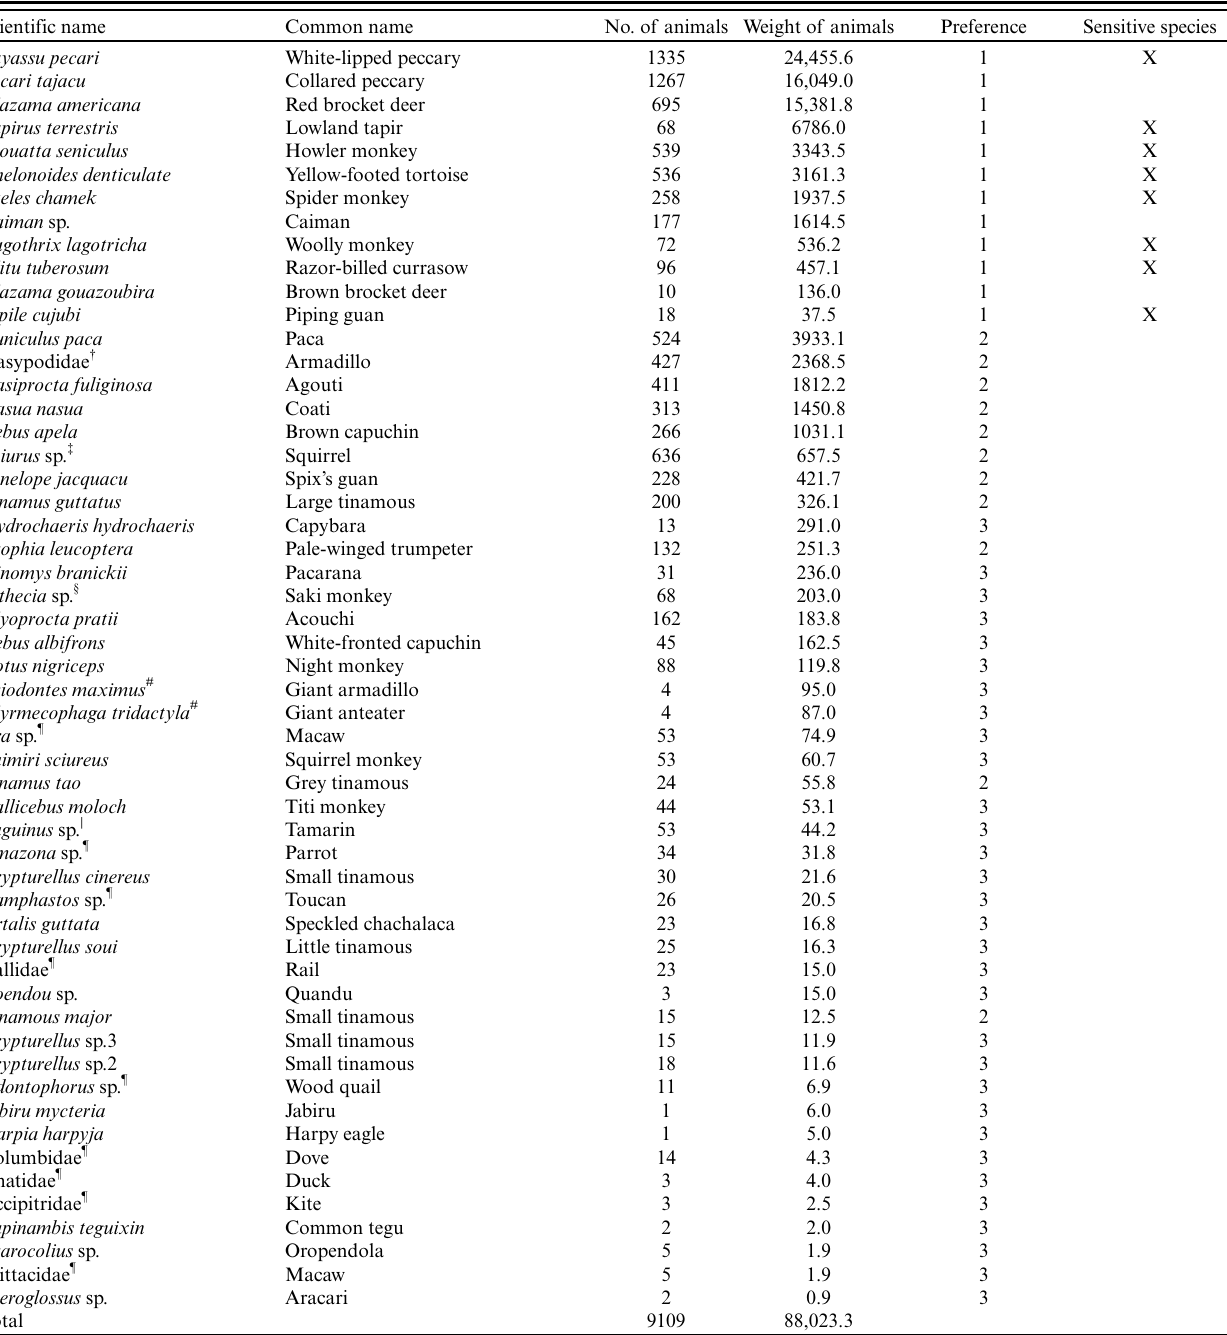
Table 1 . Wildlife species hunted by Pano communities in Acre, Brazilian Amazon, during this study. Preferred species (1), secondary species (2), and low-ranked species (3) are indicated according to Cunha and Almeida (2002) and Constantino et al. (2008). For some analysis in this study we grouped 2 and 3 representing species of secondary